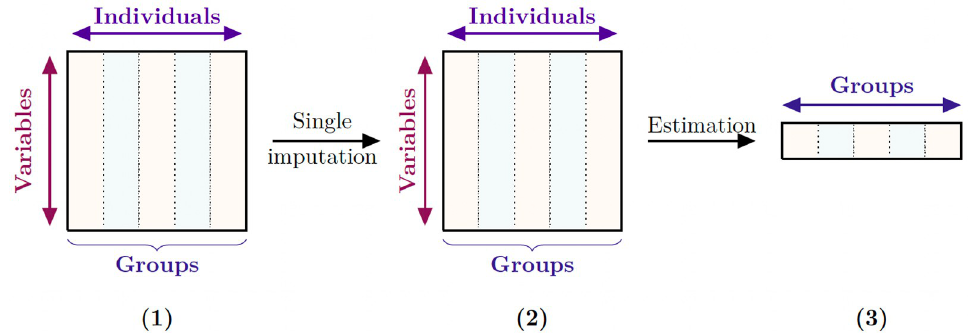
Fig 1. Single imputation strategy. (1) Initial dataset with missing values. It is supposed to be made of N observations that are split into K groups. (2) Single imputation provides an imputed dataset. (3) The vector of parameters of interest is estimated based on the single imputed dataset.